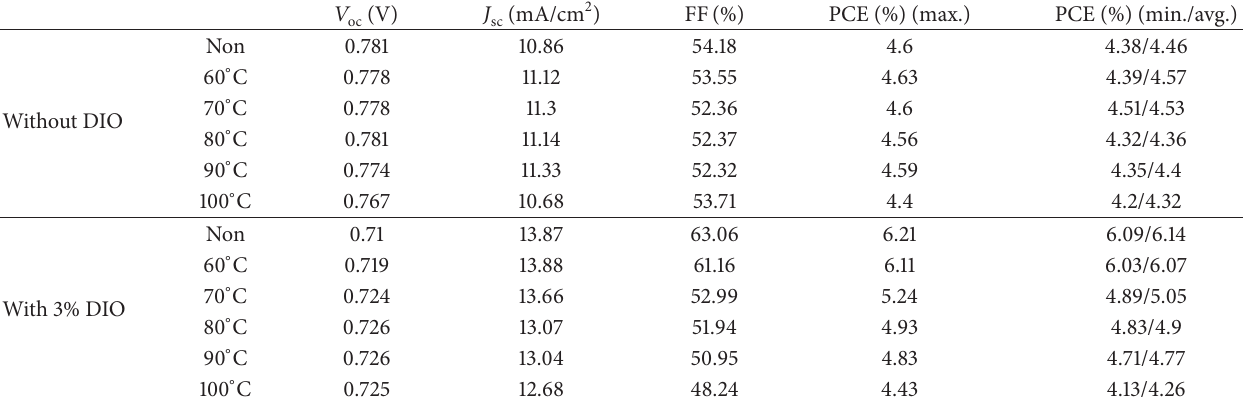
BM layers heated under different temperatures for 5 71